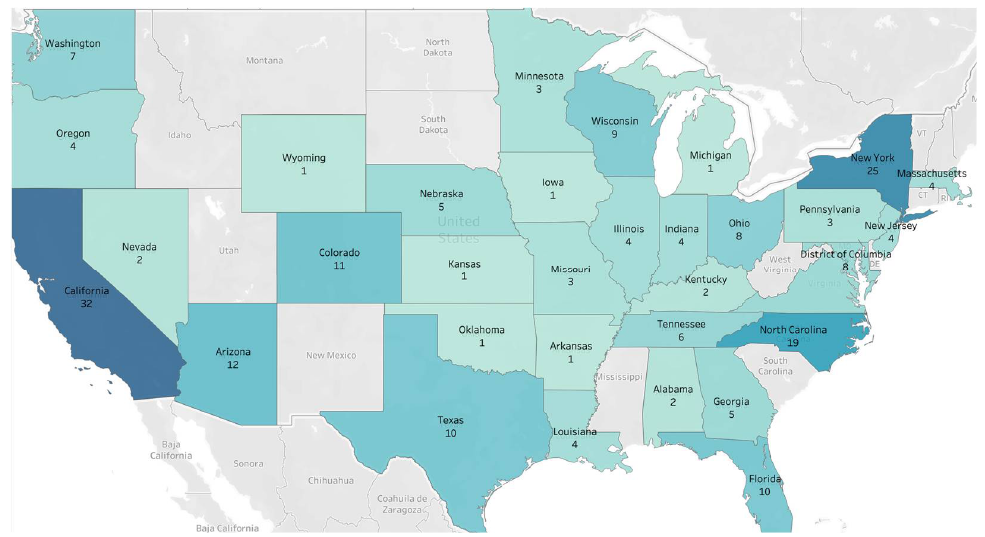
Figure 7. Transit/Mobility Policy counts by State.